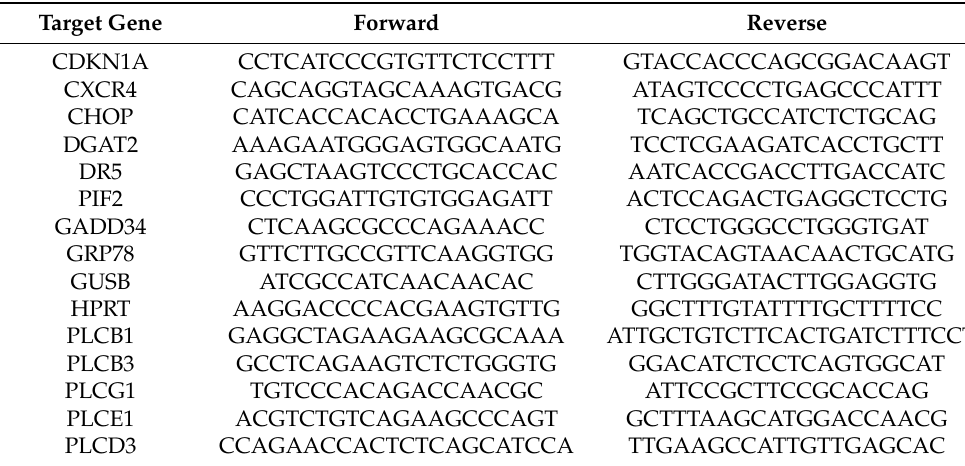
Table 2. Oligo sequences (5 (cid:48) –3 (cid:48) ) for the genes investigated. Target